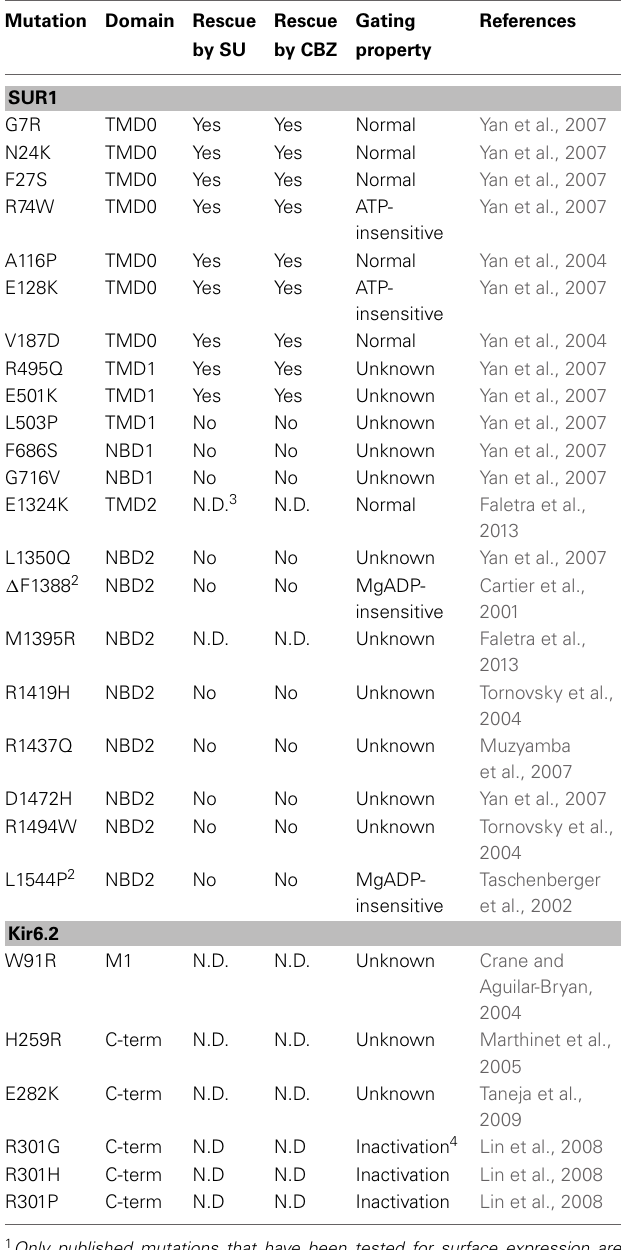
Table 1 | Congenital Hyperinsulinism-associated K ATP channel trafficking mutations and response to pharmacological rescue 1 . Mutation Domain Rescue Rescue